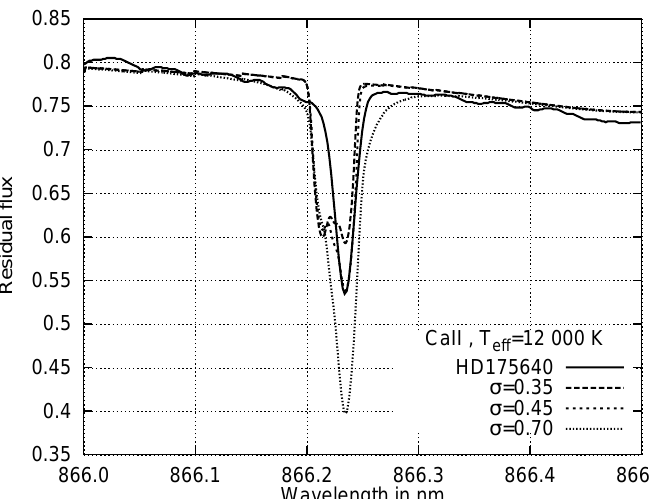
Fig. 7. Comparison of the observed line profile in HD 175640 shifted to 866.23 nm due to predominance of 48 Ca with a synthetic profile in the model stellar atmosphere with log g = 4 : 0 and T eff =12 000 K. The mean impact cross-sections (cid:27) are given in the insert in 10 (cid:0) 16 cm 2 . A good coincidence of 48 Ca line profile for (cid:27) = 3 : 5 (cid:1) 10 (cid:0) 17 cm 2 shows that the made assumptions are probably quite realistic. However, the abundances of lighter isotopes are higher than observed.